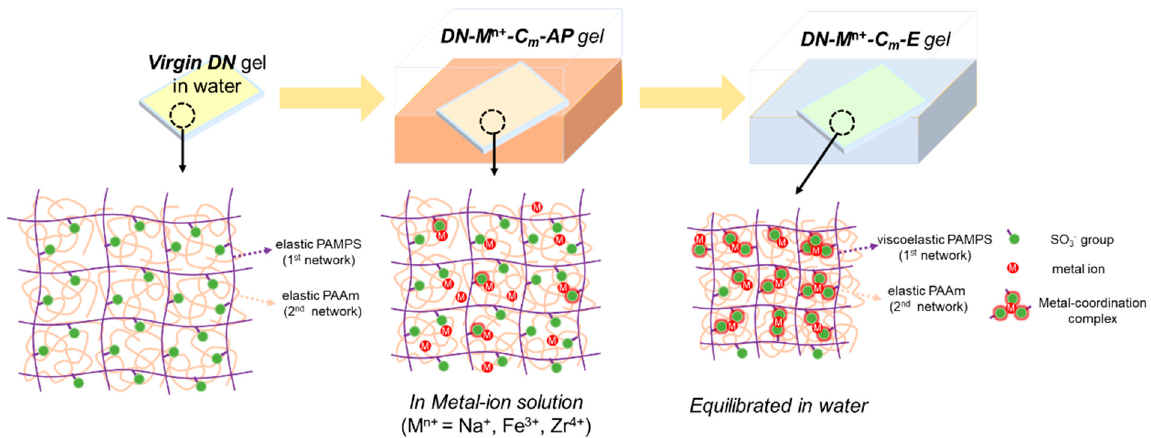
Figure 1. Schematics of design and transformation of the virgin elastic DN hydrogels to viscoelastic materials via metal-coordination complex. As-prepared DN hydrogels in metal–ion solutions are denoted as “DN − M n+ − C m − AP”, while the DN hydrogels equilibrated in water afterward are denoted as “DN − M n+ − C m − E”, where the notations “AP” and “E” mean “as-prepared” and “equilibrated”, respectively, and C m (M) represents the metal–ion concentration in solution. The metal–ions used in this work are Na + , Fe 3+, and Zr 4+ .